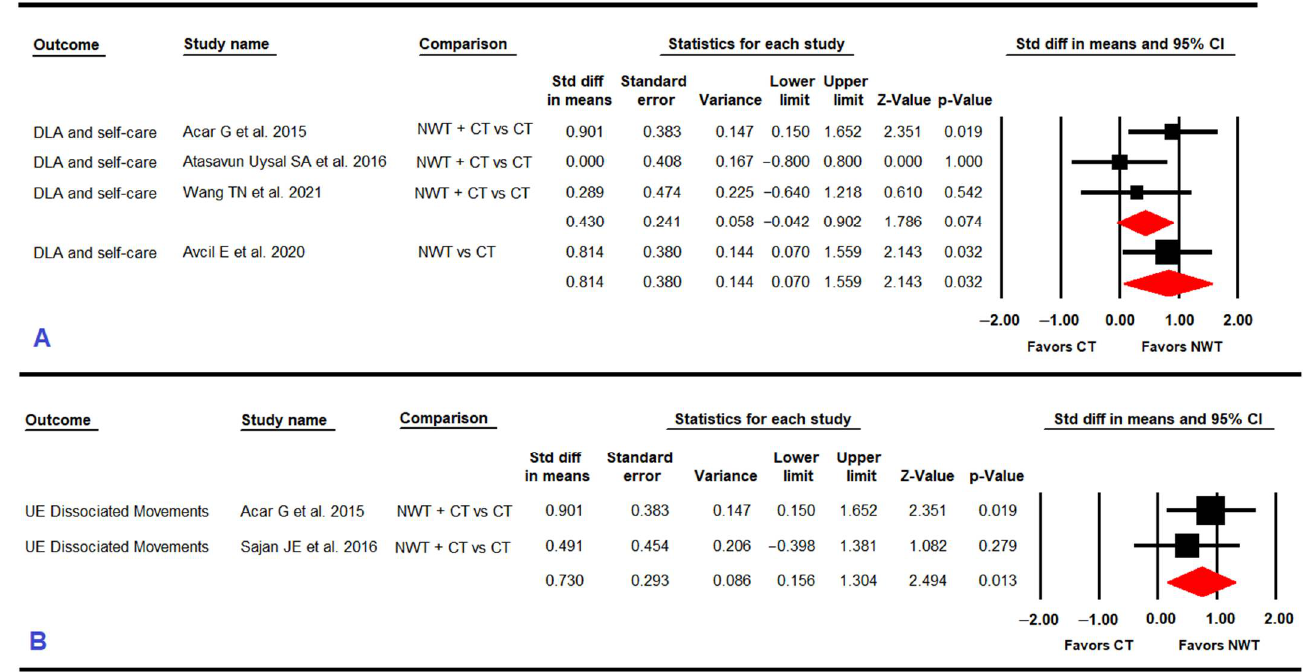
Figure 3. Forest plot effect of Nintendo ® Wii therapy on daily living activities (DLA) and self-care ( A ) and on upper extremity (UE) dissociated movements ( B ).